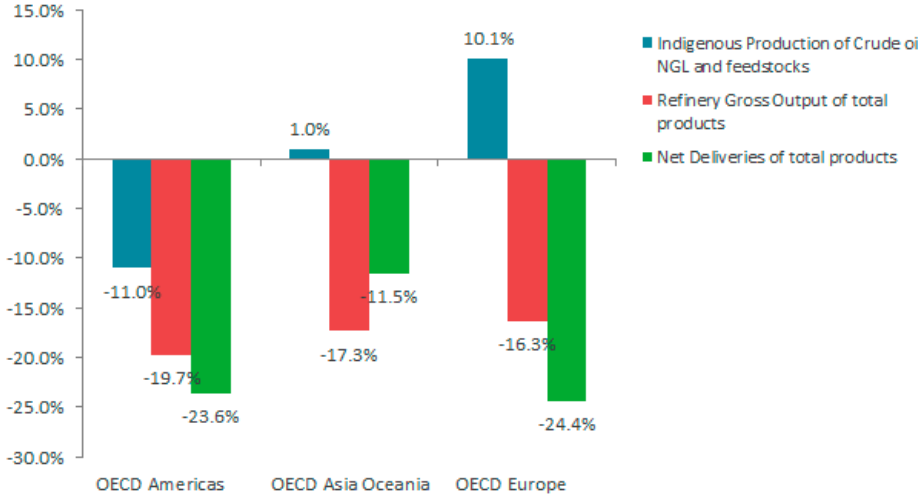
Figure 14. Growth rate per flow and OECD region in April 2020, year on year, (IEA Oil Statistics) [99].